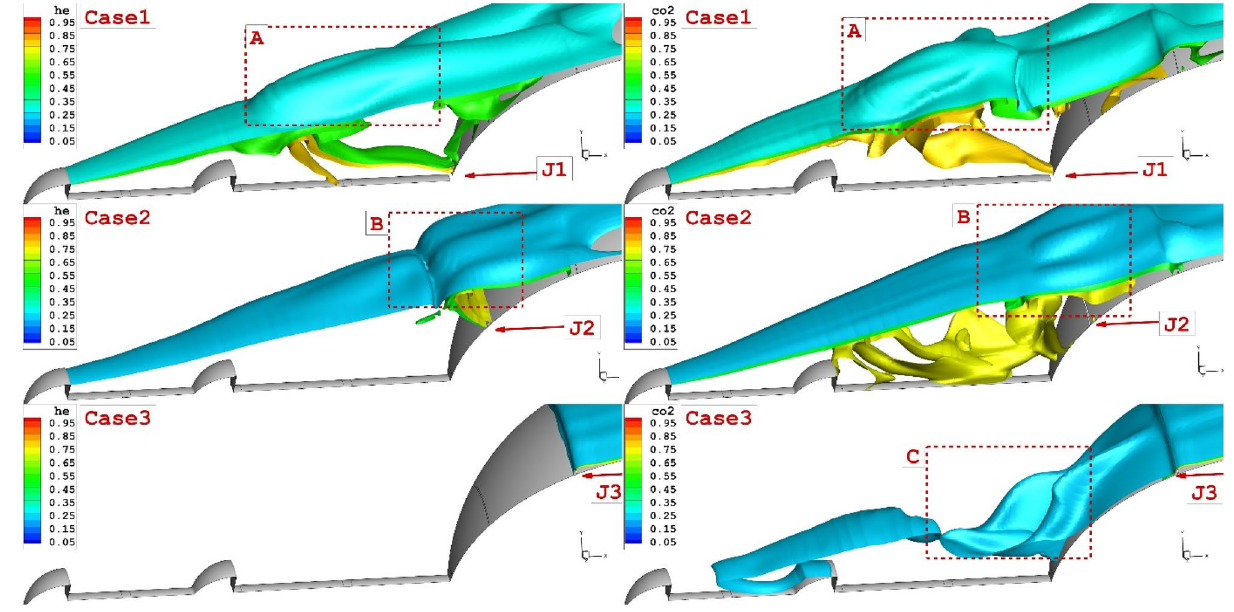
Figure 5. Effects of 3-D shock interaction of helium and CO 2 opposing jet in different location on the penetration of the coolant jets.